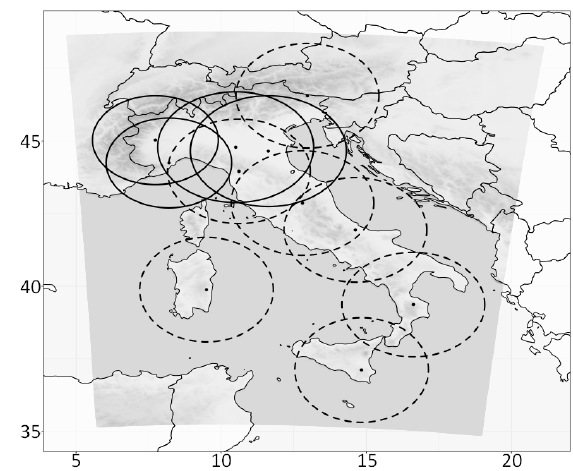
Figure 1. Integration domain (greyscale) of the COSMO model em- ployed in this study with the Italian radar network overlapped. For each radar the approximate coverage area is shown with a dashed line if the radar system contributes only to the SRI composite em- ployed in LHN and with a solid line if it is used also to directly assimilate reflectivity volumes through